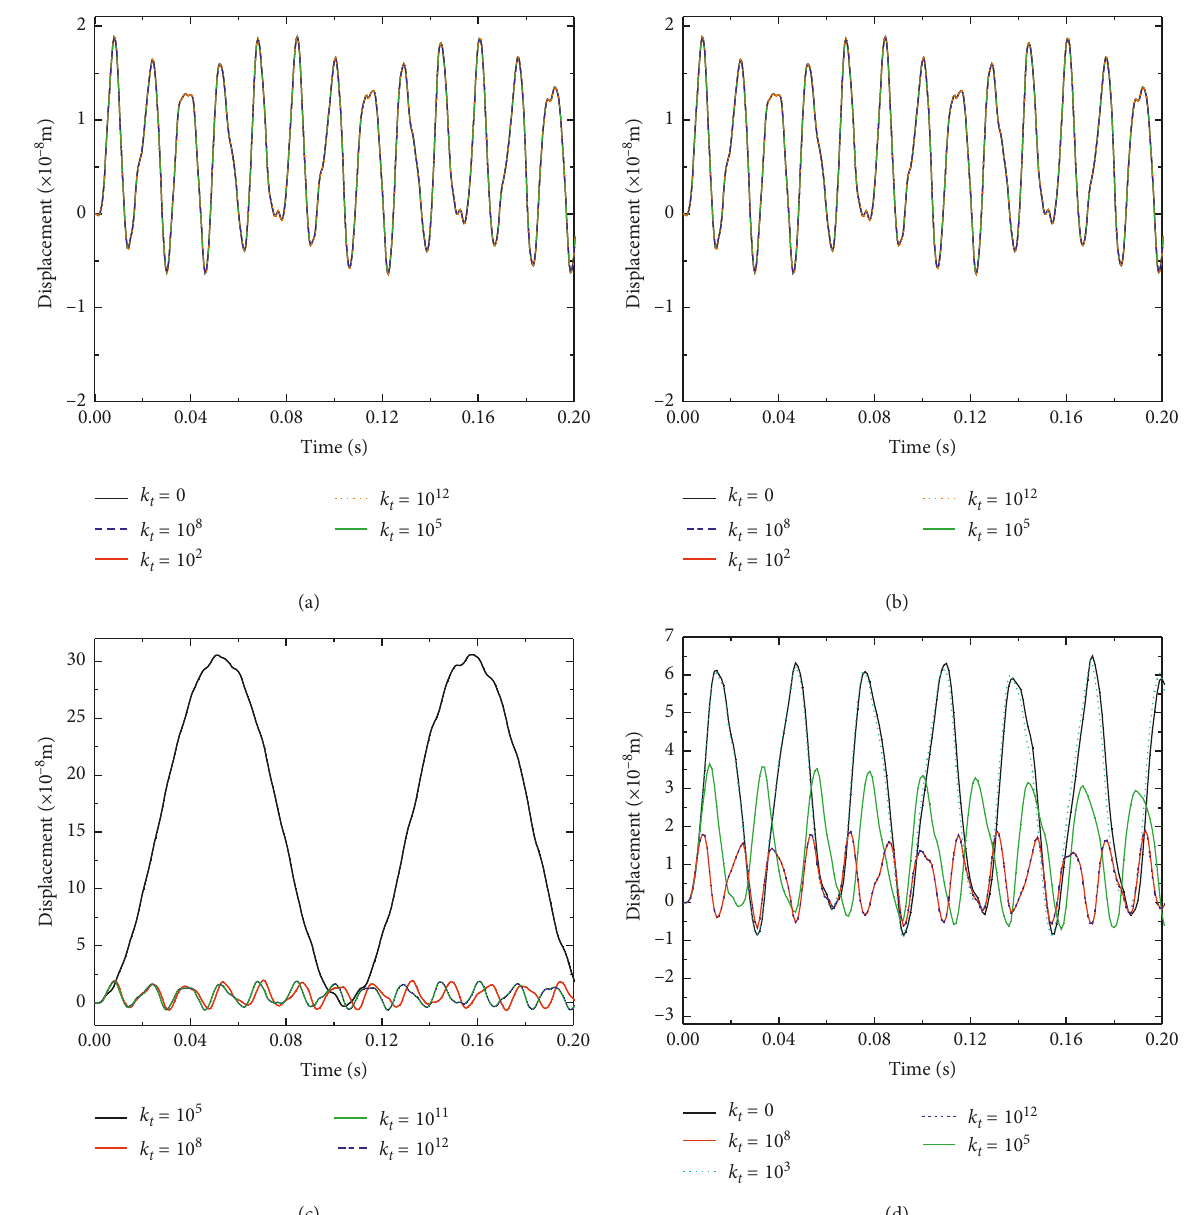
Figure 18: Effect of the boundary spring stiffness on transient response of stiffened plate under local uniform pressure ( p spring: k u . (b) Linear spring: k v . (c) Linear spring: k w . (d) Rotational spring: K w